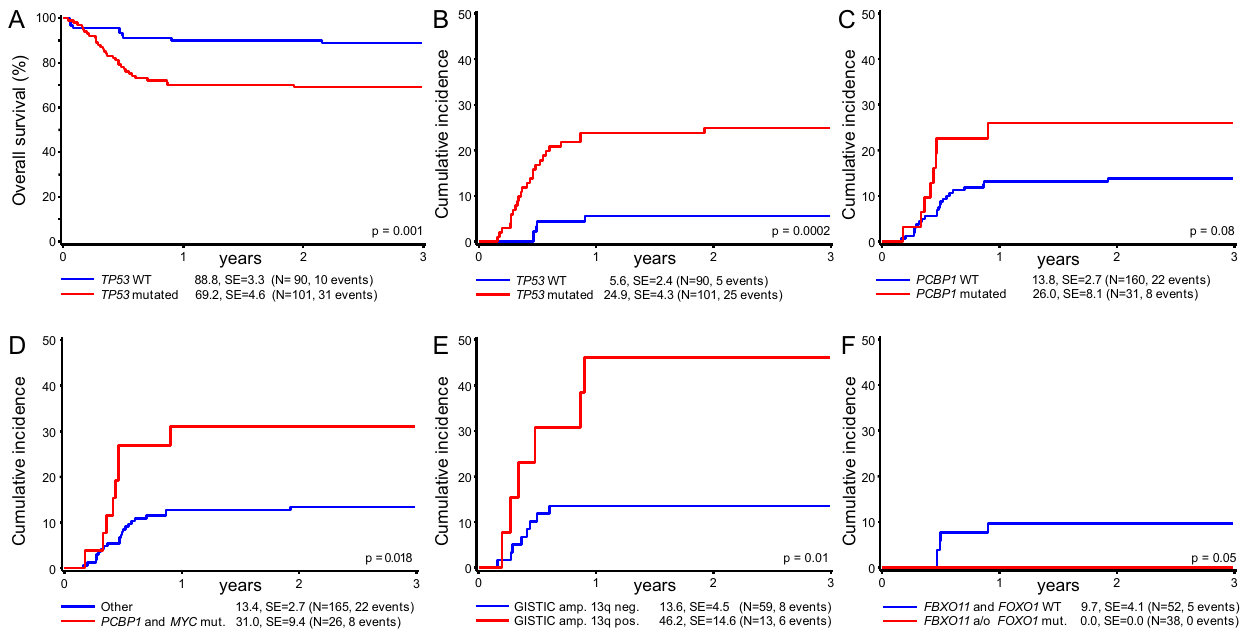
Fig. 5 Mutations associated with survival and cumulative incidence of relapse in the pediatric cohort. A The overall survival for pediatric patients with SNV/indels in TP53 was signi fi cantly inferior to patients with TP53 wild-type (Kaplan – Meier survival estimation, log-rank test). B TP53 mut cases also showed an increased risk of relapse (cumulative incidence, Gray ’ s test 20 , no adjustments for multiple comparisons in this descriptive context). C Mutations in PCBP1 show a tendency toward prognostic relevance. D Cases with lymphomas harboring MYC and PCBP1 mutations are characterized by an increased risk of relapse. Gains or ampli fi cations on 13q31 speci fi c to GPC5/MIR17HG were signi fi cantly associated with a higher risk of relapse ( E ). The lowest incidence of relapse (0/38 cases) was observed for the TP53 wt sub-group and mutations in FBXO11/FOXO1 ( F